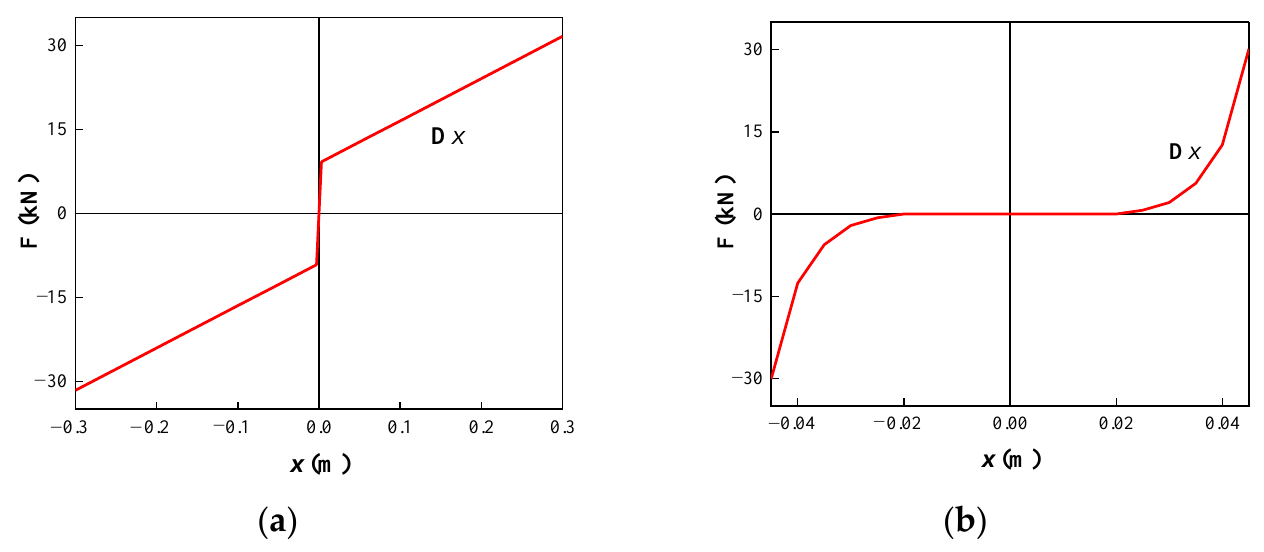
Figure 3. Nonlinear suspension stiffness: ( a ) the anti-yaw damper and ( b ) the lateral stop. Table 1. Vehicle parameters.